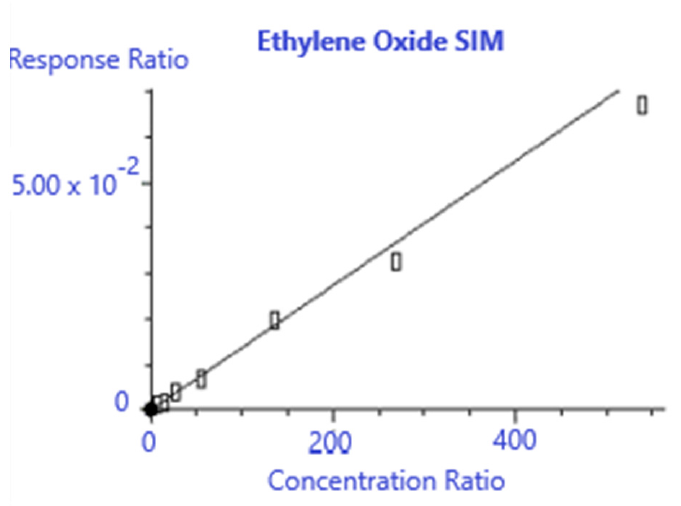
Figure 5. Ethylene oxide calibration results.